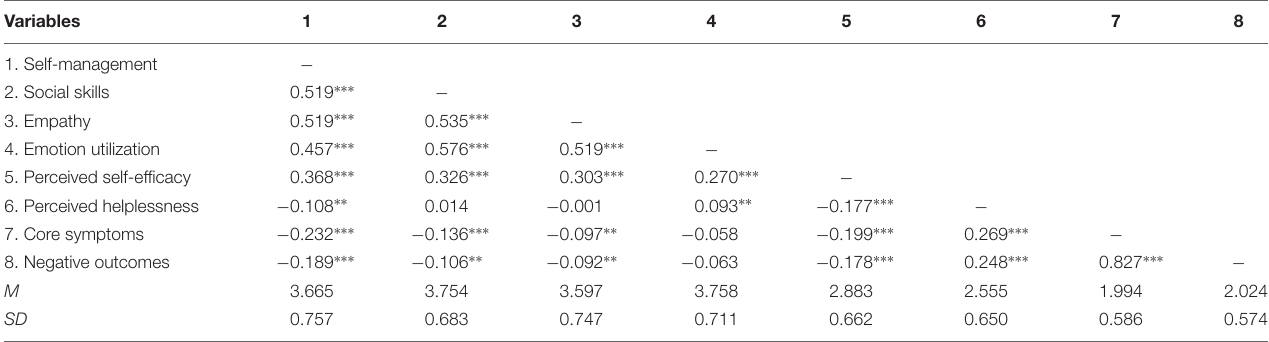
TABLE 1 | Descriptive statistics and intercorrelations for the major